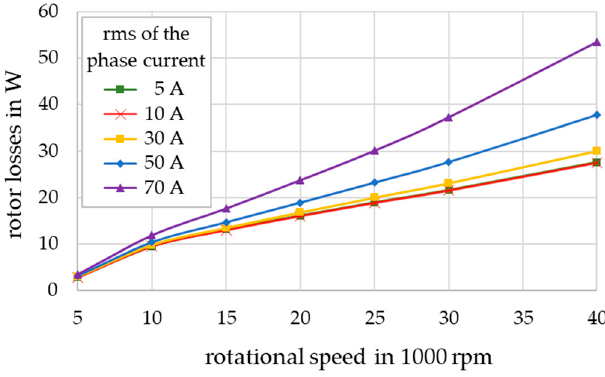
Figure 7. Rotor losses of the permanent magnet synchronous machine.